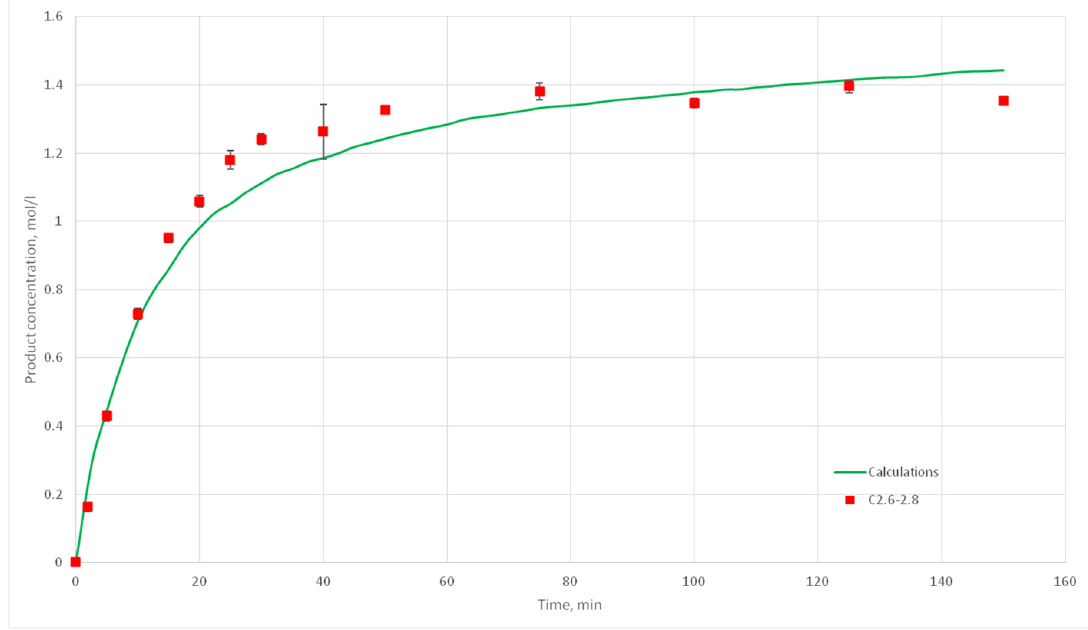
Figure 20. Calculation and experimental reaction kinetic curves for С 2.6, 2.7 и 2.8 experiments.